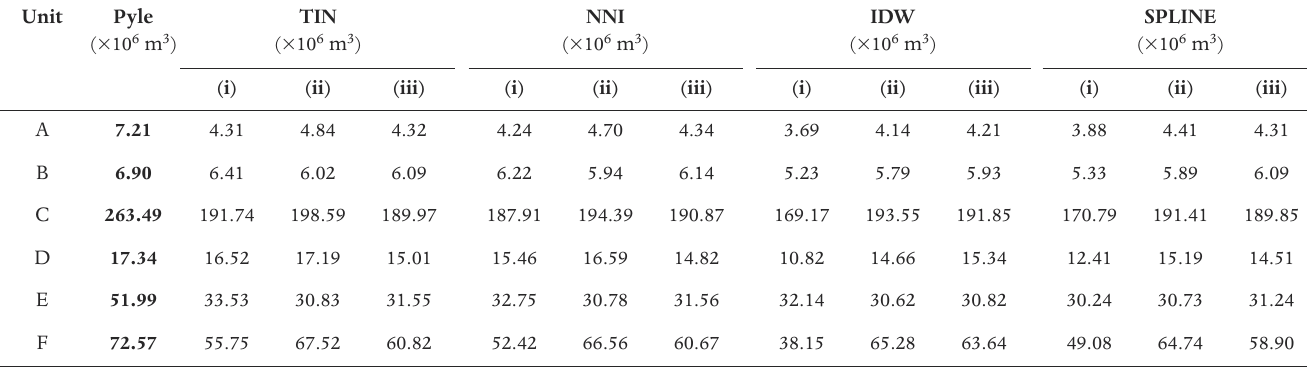
Table 2. Volumes of the studied volcanic units (A-F) calculated using the different methodologies (Pyle, TIN, NNI, IDW, SPLINE) and modes (i, ii, iii). See text for explanation.